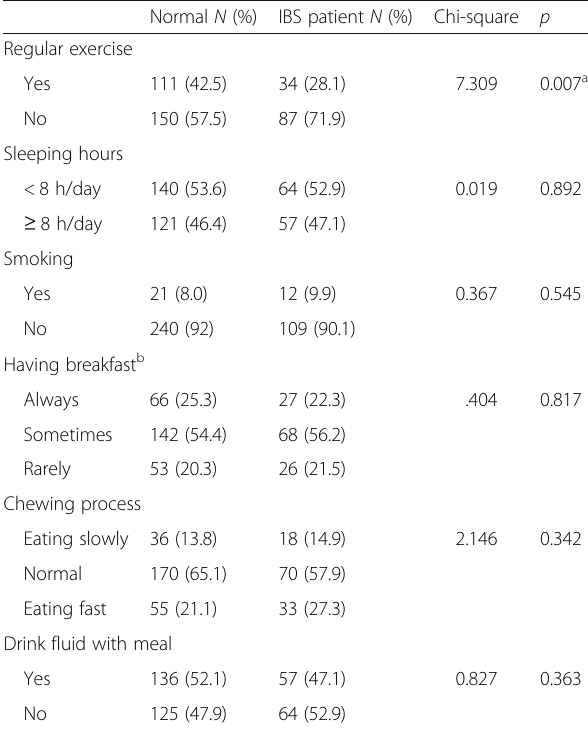
Table 2 Comparison between IBS patients and normal students regarding lifestyle characteristics